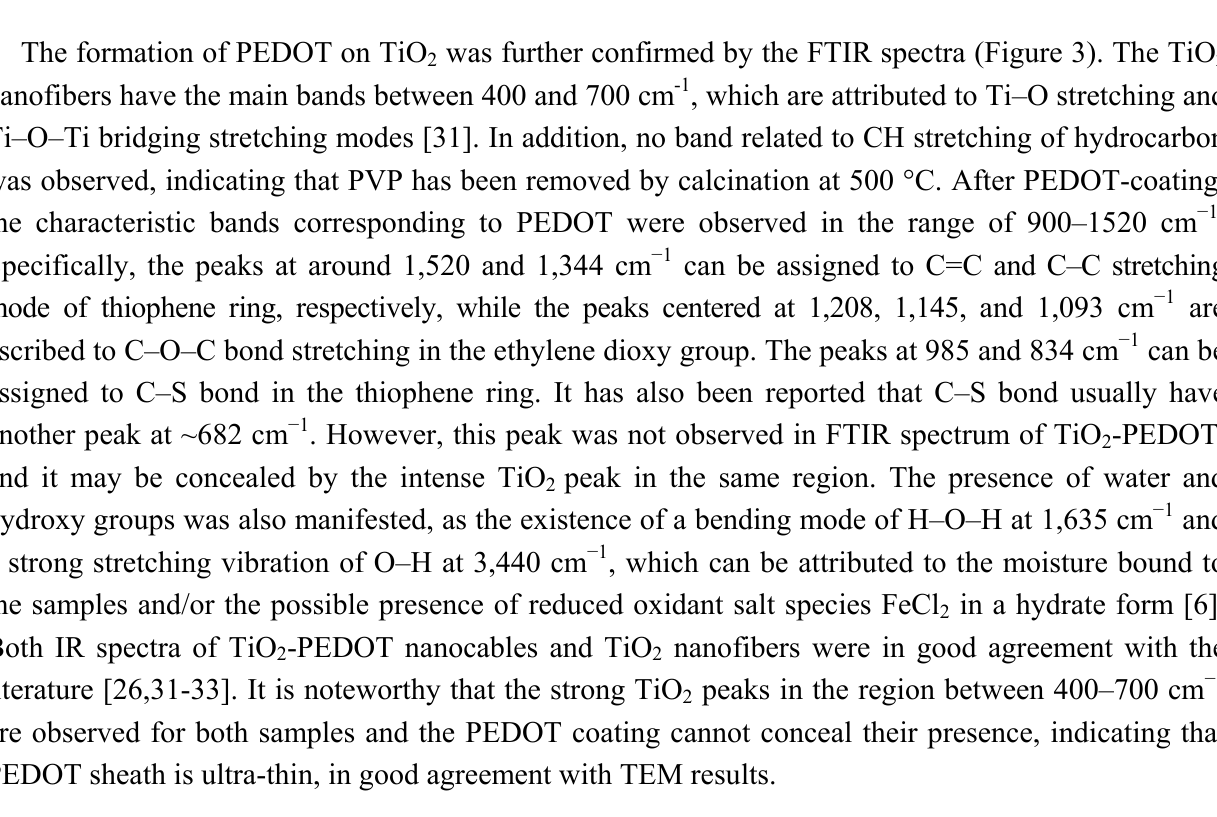
Figure 3. FTIR spectra of the electrospun TiO